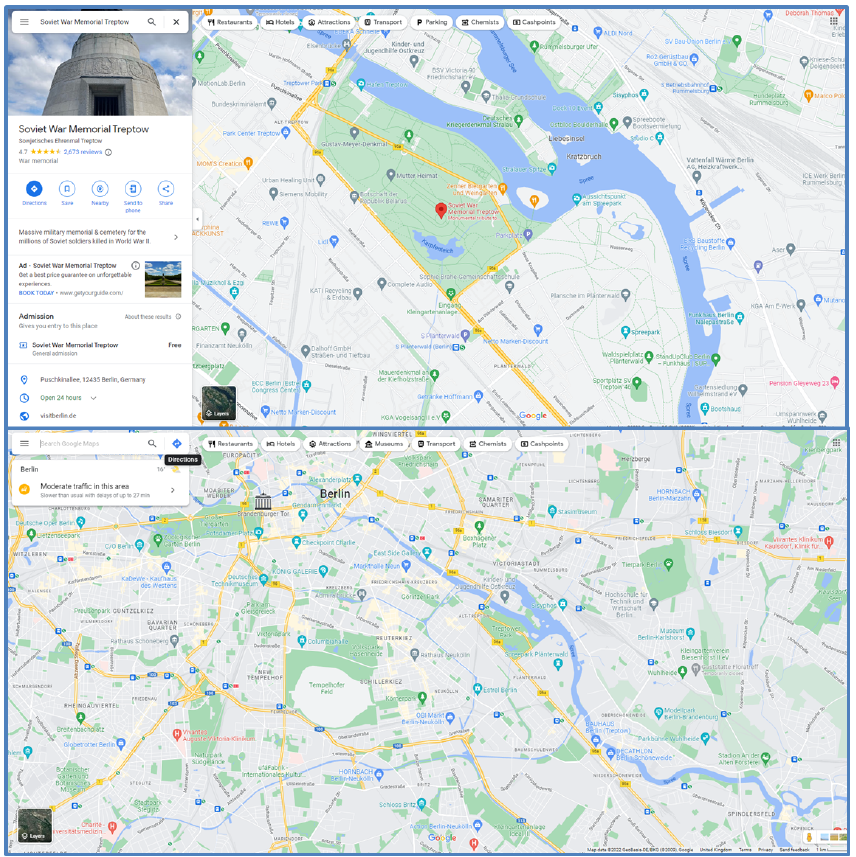
Figure 3. Zoomed-in view of the Berlin memorial of the Soviet War on top and a view at a smaller scale, where the Y-shaped river section can be used to find the memorial (source: